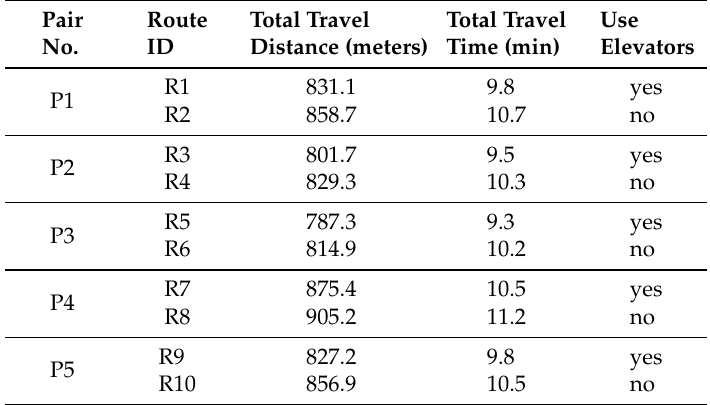
Table 3. Calculated results for Case